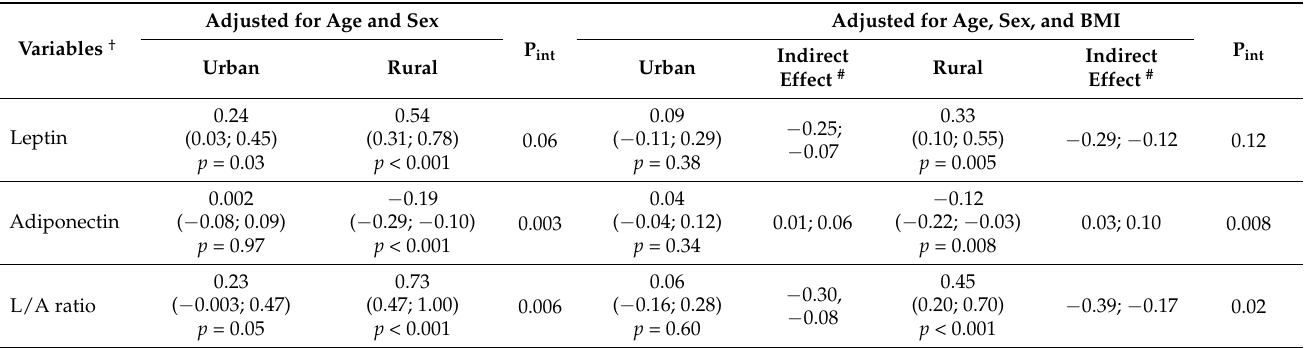
Figure 2. Changes of leptin levels ( A ), adiponectin levels ( B ), and leptin-adiponectin (L/A) ratio ( C ) in urban and rural subjects after 1-year of living in an urban environment. The changes are presented as estimate and 95% confidence interval (95%CI). The changes in each group and the differences of changes between urban and rural group for each parameter were analyzed using a linear-mixed model, adjusted for age and sex. All parameters were log-transformed (base 2) for analysis. The estimates (95%CIs) were back-transformed (2 β ) and presented as percent changes compared to baseline. The p -value depicted in the figure represents the p -value for interaction (P int ), the level of significance in the differences of changes between the two groups. * p < 0.05. Table 2. Mediation analysis of the effect of changes in BMI overtime on the leptin, adiponectin, and L/A ratio in urban and rural subjects at 1-year follow-up.